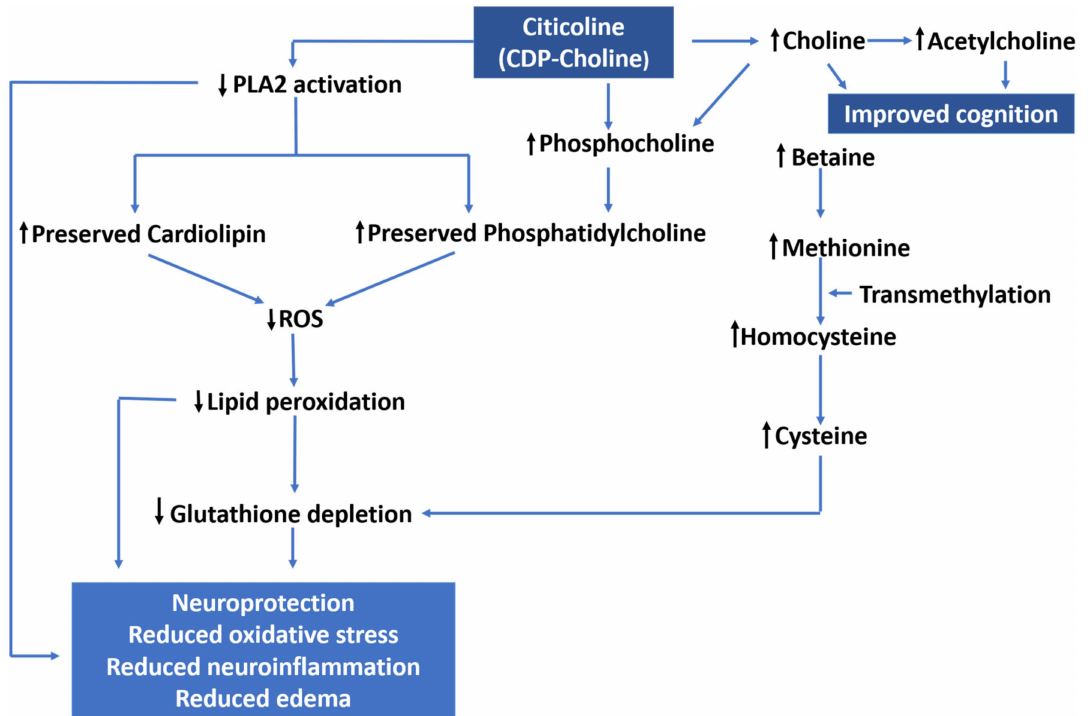
Figure 7. Proposed mechanism of action of Citicoline (CDP-choline) to ameliorate the pathogenesis of TBI. Citicoline decreases the expression of PLA2, resulting in the preservation of cardiolipin and phosphatidylcholine in the brain, which eventually result into reduced ( ↓ ) oxygen species andlipid peroxidation and increased ( ↑ ) glutathione levels, which is lsimultaneously supplemented through the cysteine–choline pathway as well. On the other hand, the citicoline also increases acetylcholine, boosts cholinergic neurotransmission and post-TBI cognition. Phosphocholine generated from citicoline also directly yields phosphatidylcholine, the essential constituent of the membrane